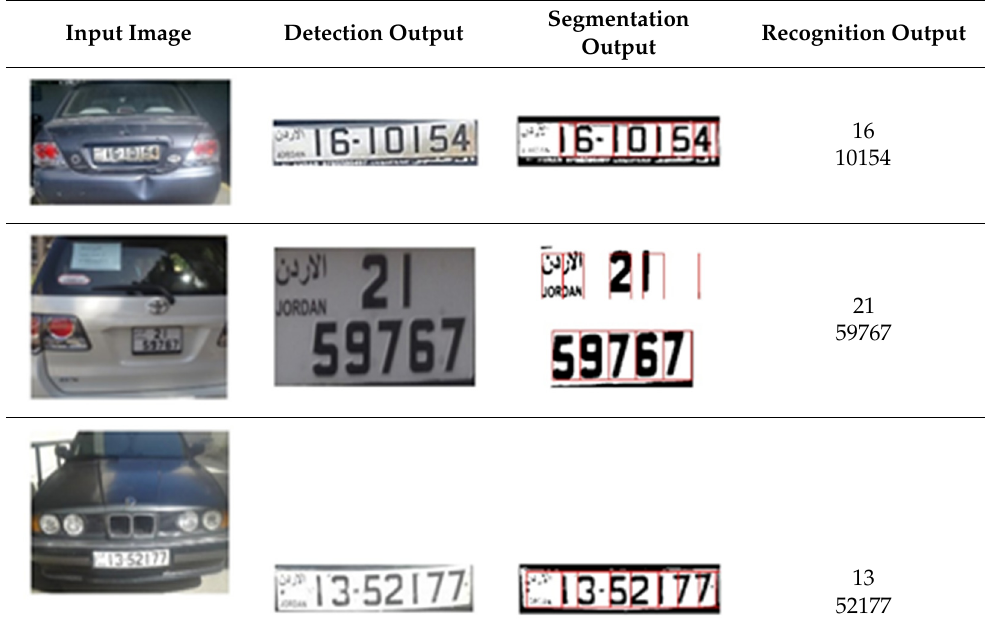
Table 2. Sample input images, and corresponding detection, segmentation, and recognition results.